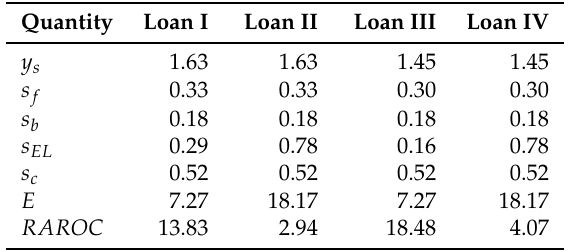
Table 4. Cost components RAROC for the four example loans assuming rating grade 3 and using the Internal Ratings Based Approach for computing E . All results are percentage values.